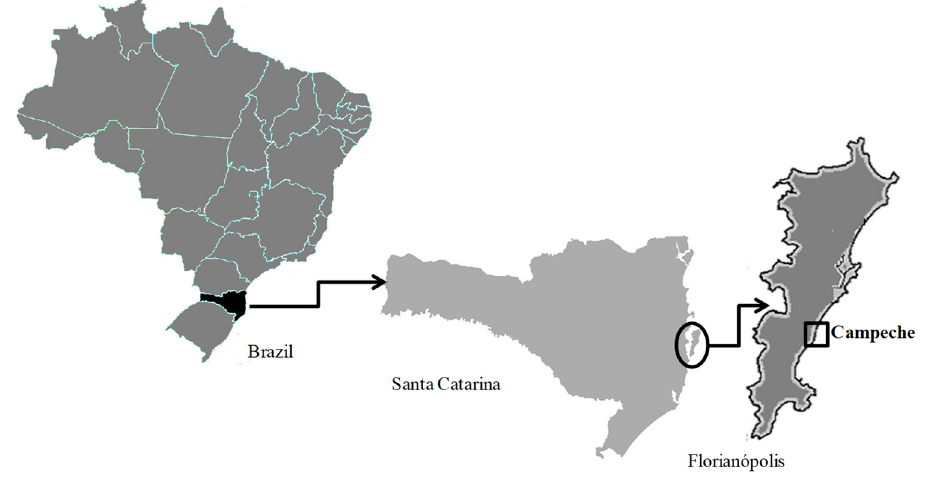
Figure 2. Location of the case study.